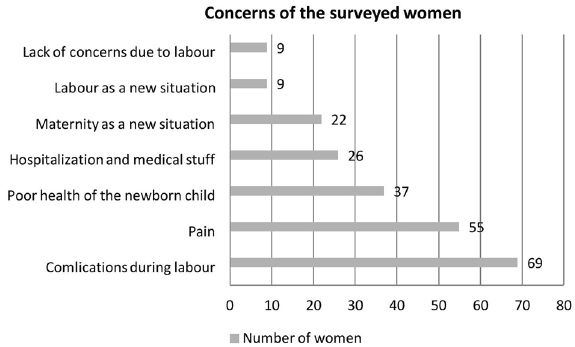
Figure 2. Concerns of the surveyed